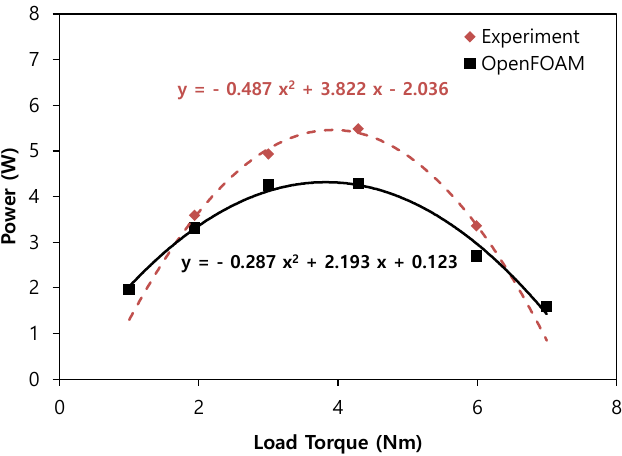
Figure 6. Comparison of the extracted power at H = 0.136 m and T = 1.432 s.